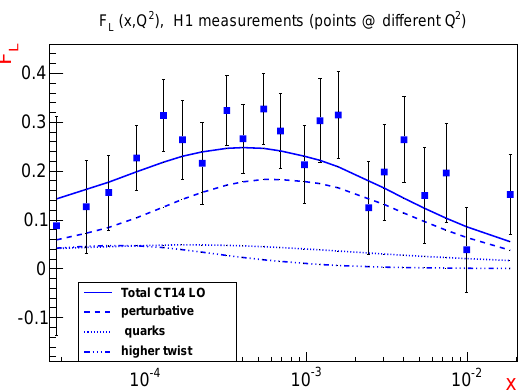
Figure 2: The results from the model for F contributions and compared to the HERA data from H1 experiment [ 4 ] .